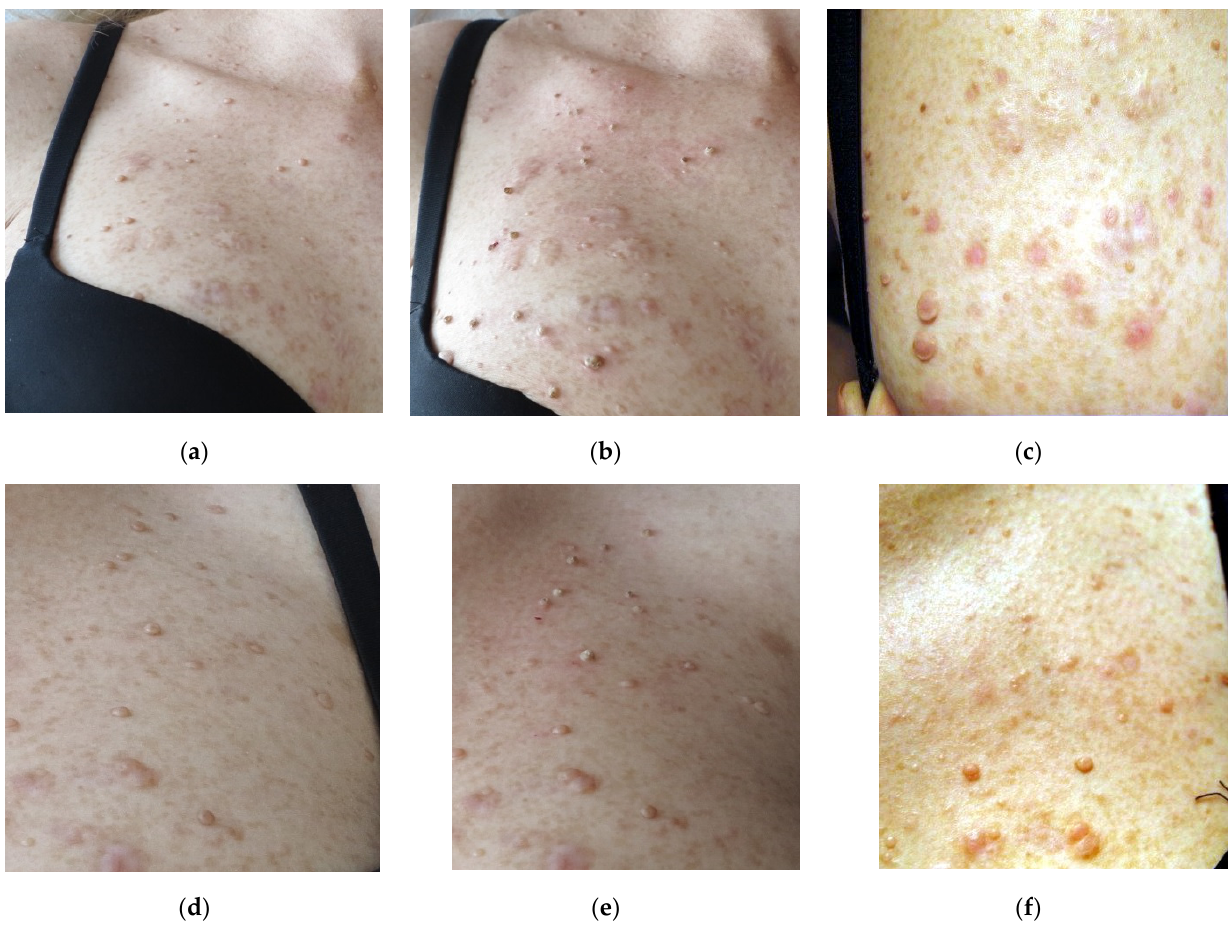
Figure 7. Laser therapy of dermal neurofibroma at right side of the décolleté area using DL radiation with wavelengths 975 nm: and cw power 10 W; ( a ) view before irradiation, ( b ) soon after irradiation ( c ) 7 weeks after laser treatment; and with pulsed power 15W (pulse 50 ms, 10 Hz) left side of the décolleté area ( d ) view before irradiation, ( e ) soon after irradiation ( f ) 7 weeks after laser treatment.